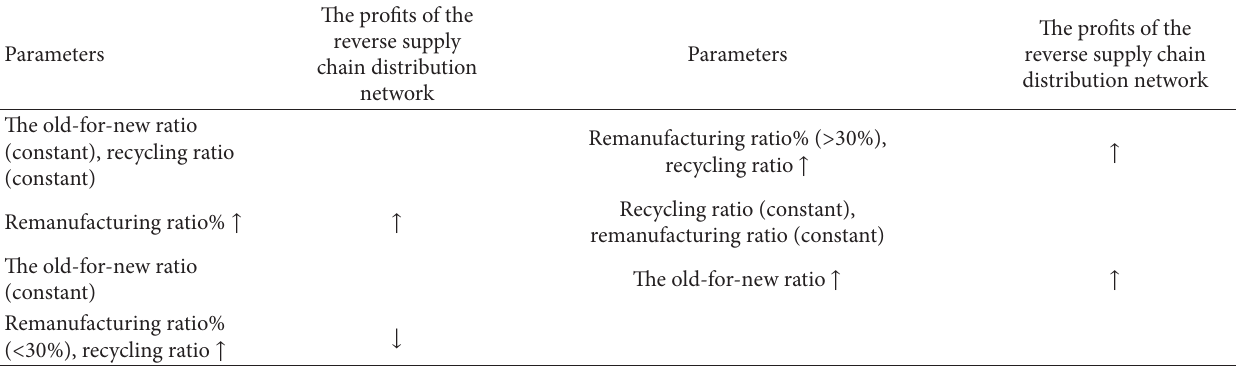
Table 5: The old-for-new ratio, remanufacturing ratio, and recycling ratio influence on the profits in supply chain.